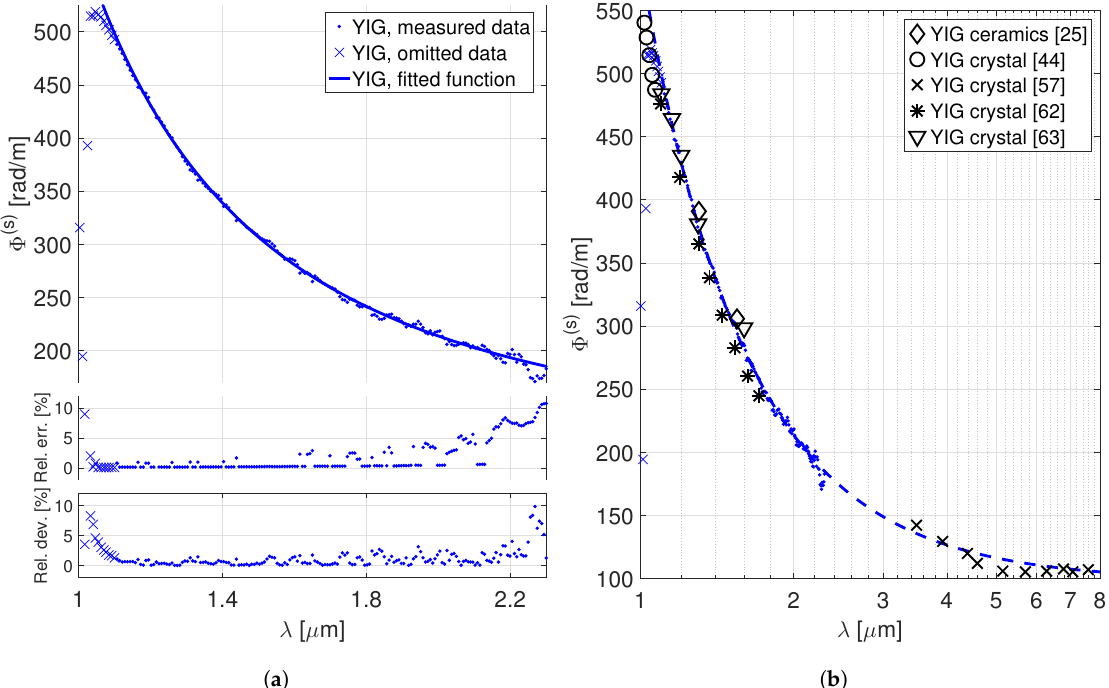
Figure 4. Dispersion of the specific Faraday rotation of the YIG crystal in the saturated regime. ( a ) The measured data, omitted data for the fit, fitted model (the top-most plot). Relative errors of the measurement, relative deviations of the data from the fitted model (the two bottom-most plots). ( b ) Comparison with the values that may be found in the available